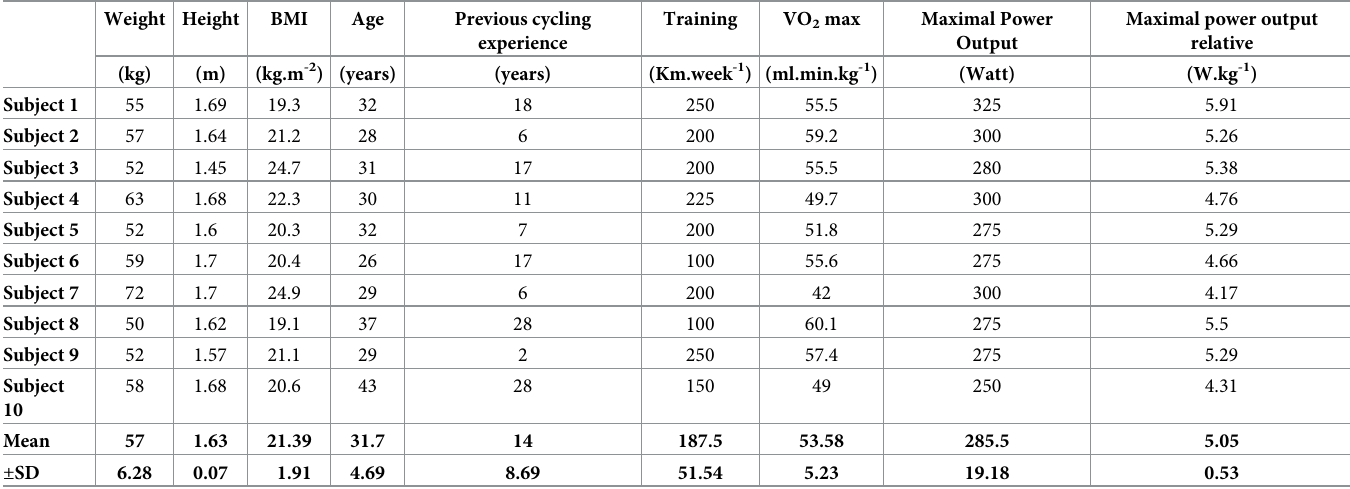
Table 2. Characteristics of the subjects. Weight